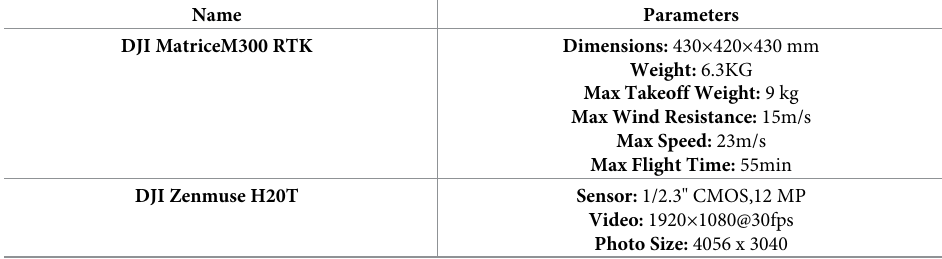
Table 1. Parameters for data acquisition equipment.